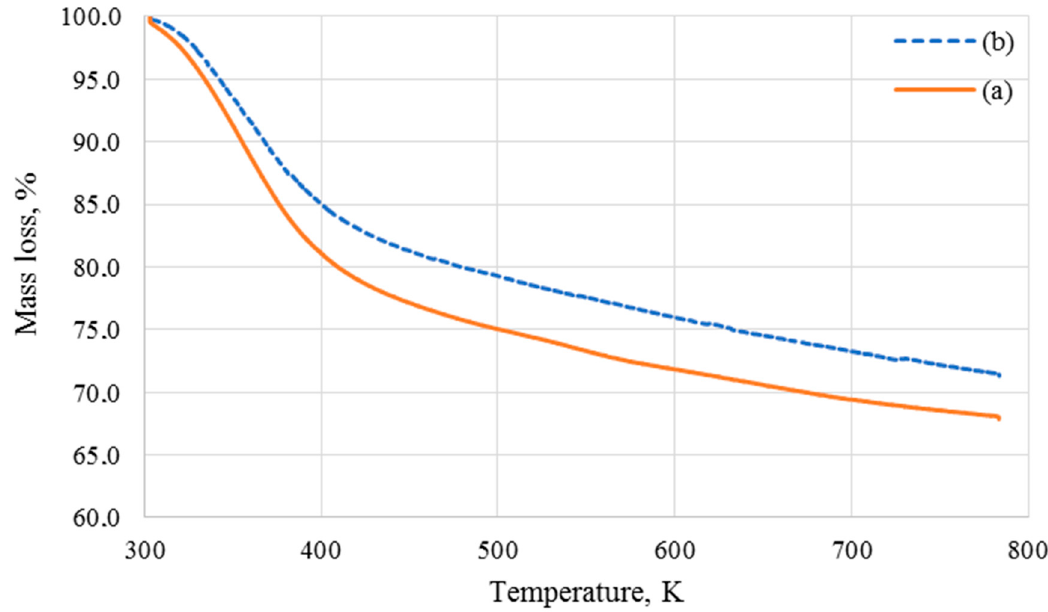
Figure 4. TGA for the: ( a ) magnetic core-shells Fe 3 O 4 / TiO 2 ; ( b ) Fe 3 O 4 / TiO 2 / [FeCl 2 { κ 3 -HC(pz) 3 }].